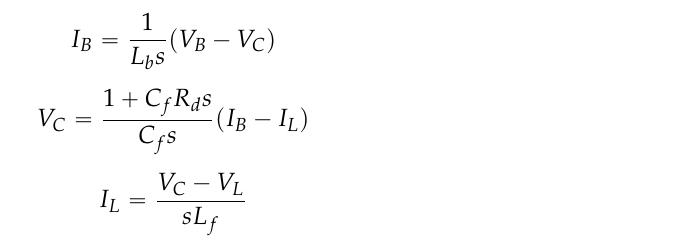
Figure 4. Equivalent circuit of the entire system.